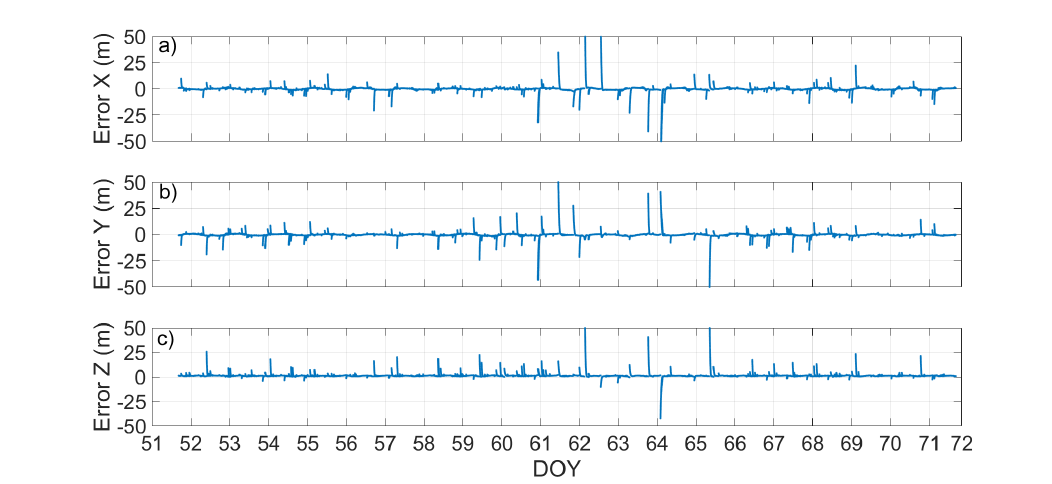
Figure 17. Orbital error of the Doresa (E18) satellite plotted versus time. The ticks on the x-axis are spaced 86,400 s (equal to one day); in this way, each tick corresponds to a day.